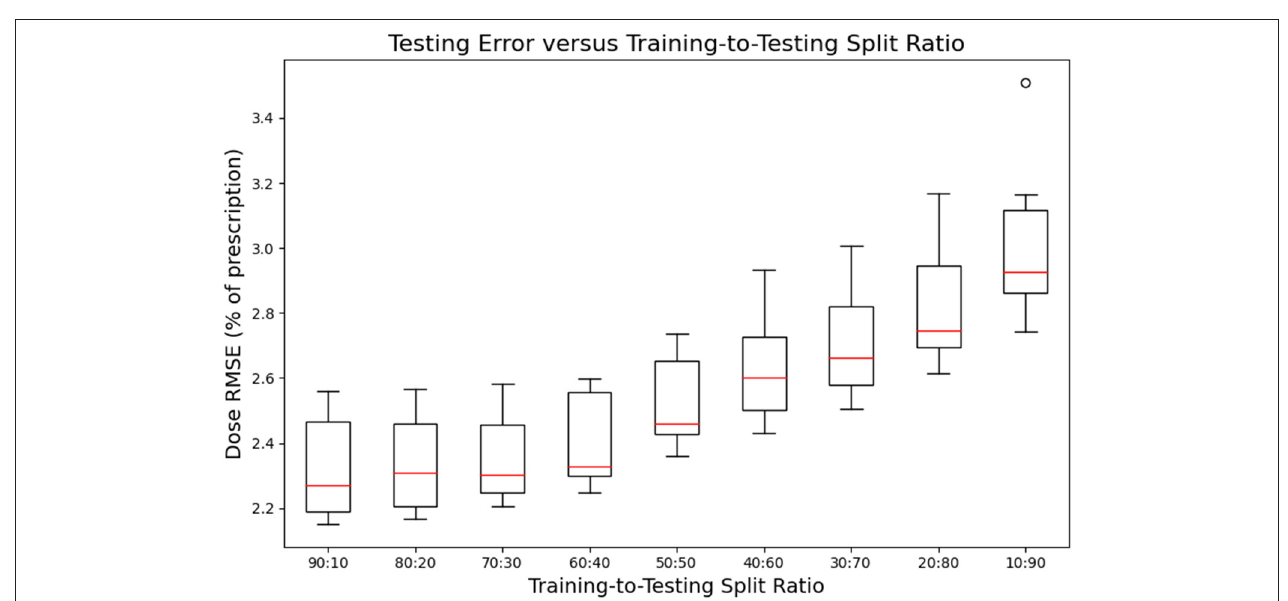
FIGURE 8 | Box-and-whisker plots representing the testing set errors of the model as a function of decreasing training-to-testing set split ratios. Each box-and-whisker plot represents the aggregate errors from one split of 10-fold cross-validation.